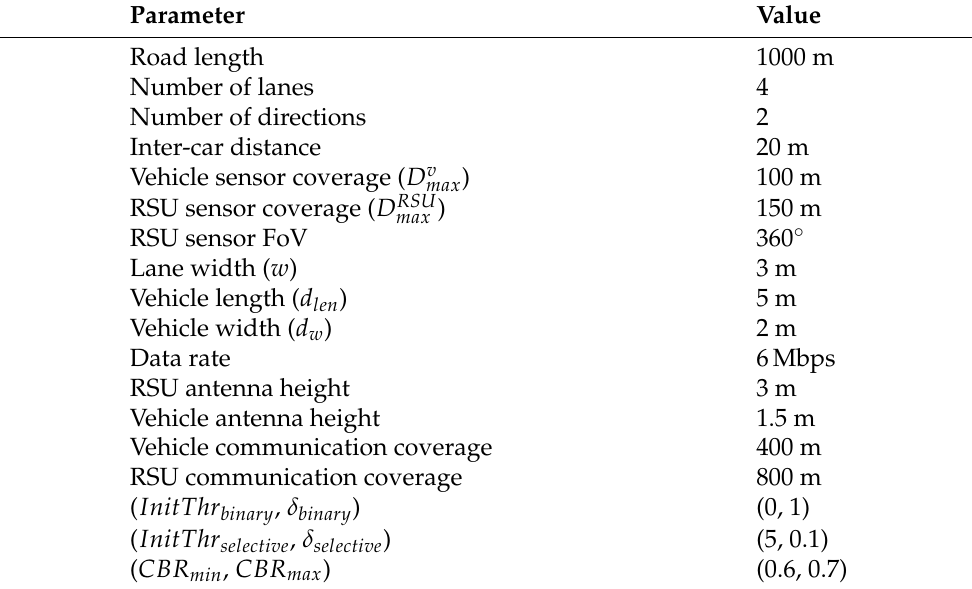
Table 3. Simulation parameters.